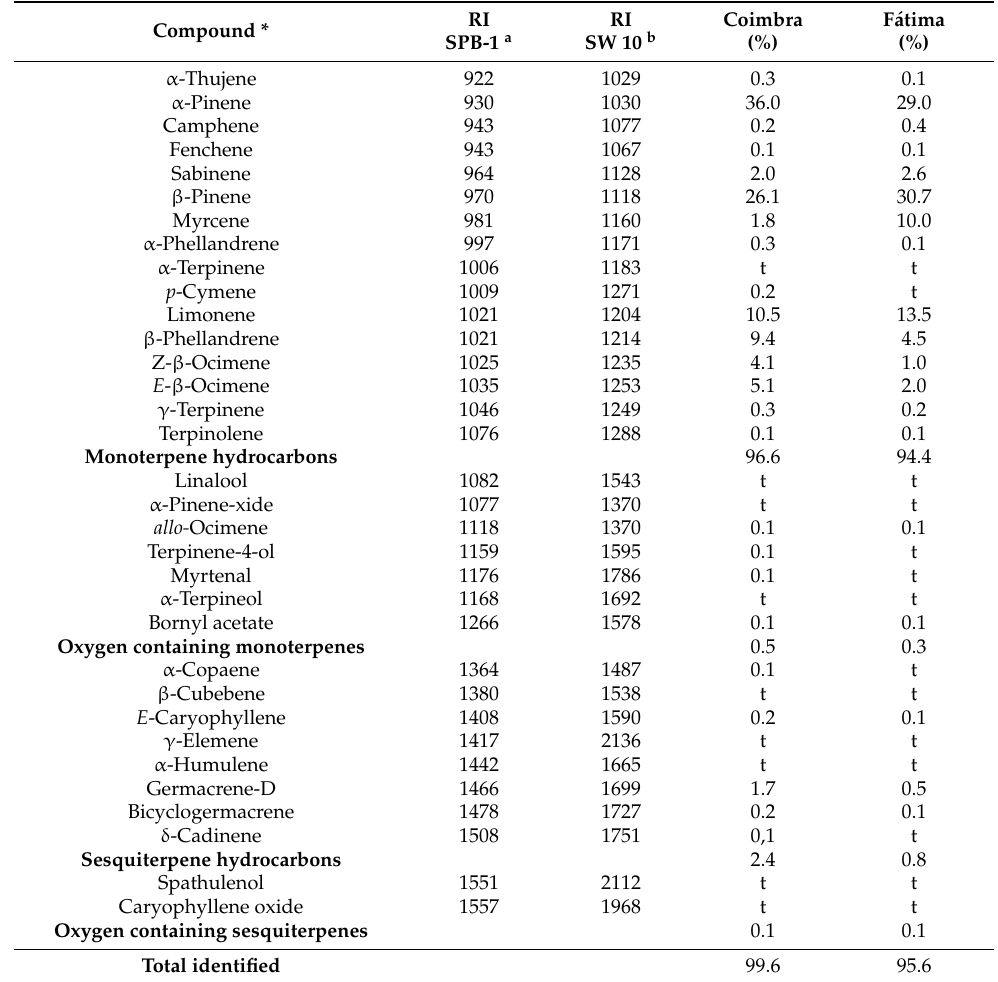
Table 1. Chemical composition of Portuguese Bupleurum rigidum subsp. paniculatum essential oil. Compound